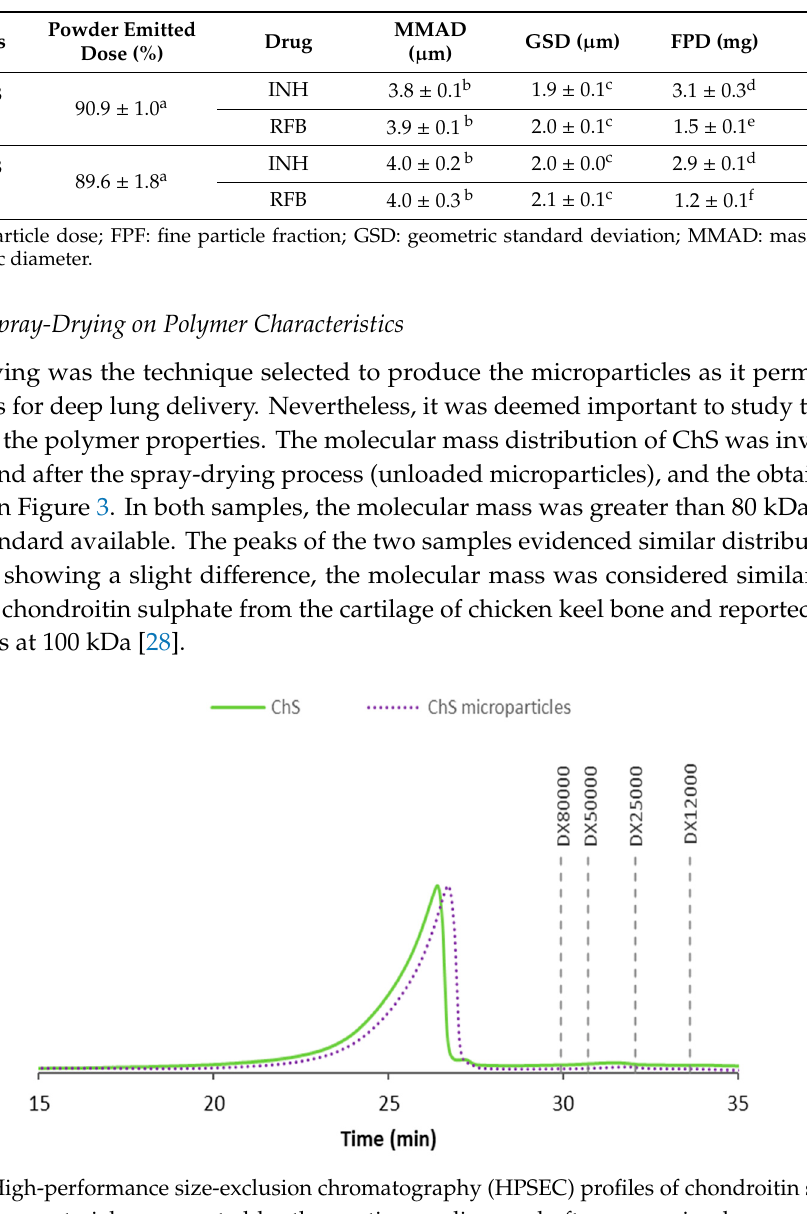
Table 3. Aerodynamic characteristics of ChS / INH / RFB (10 / 1 / 0.5, w / w) microparticles (mean ± SD, n = 3). Di ff erent letters indicate statistically significant di ff erence within the same parameter ( p < 0.05).